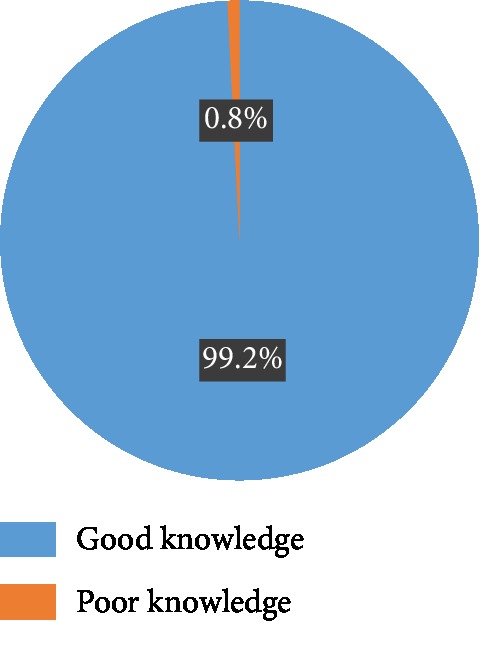
Knowledge of intimate partner violence.